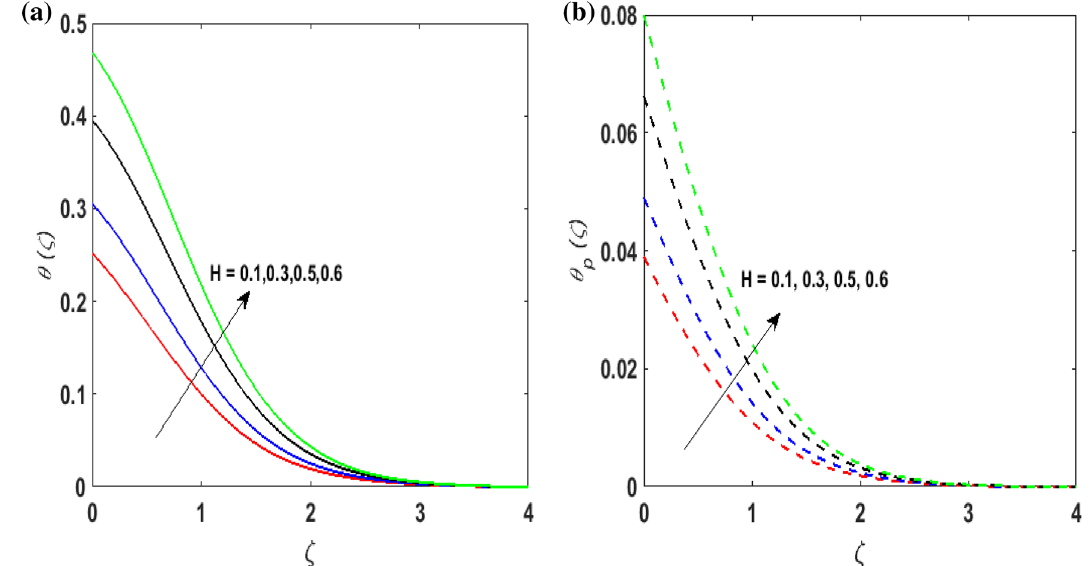
Figure 12. ( a ) θ(ζ) for various H > 0. ( b ) θ p (ζ) for various H > 0.